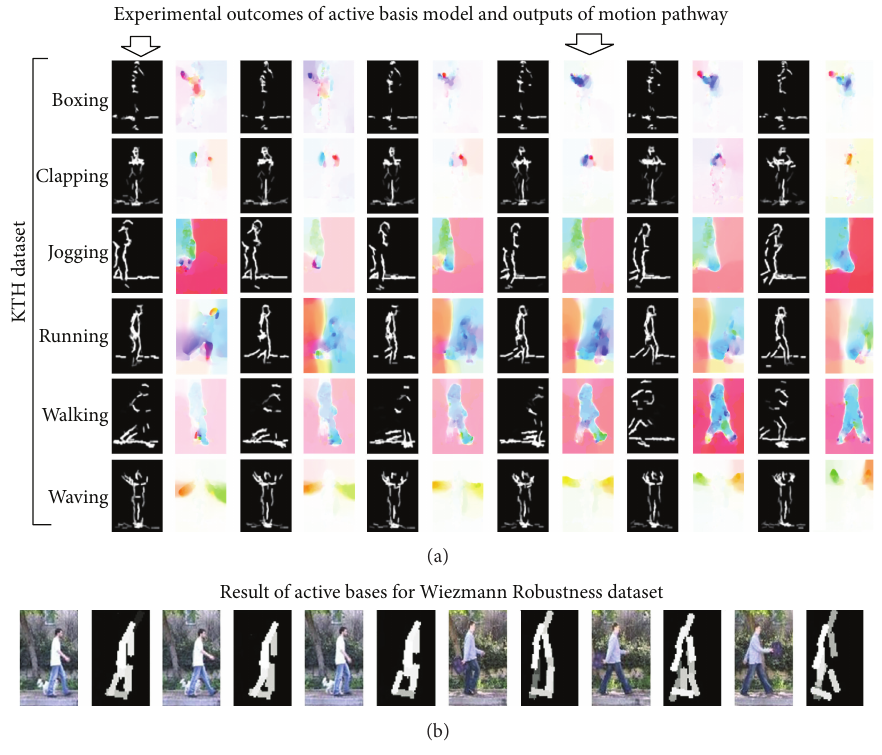
Figure 7: Simulation results for simple biological movement paradigm based on ABM [24] in the ventral processing stream and optical flow [25] in dorsal stream are shown. Each row within the panel reveals the response of ABM during the episode as well as flow generated for every different action. The set of biological movements that belongs to the biological movements is from KTH dataset [39]. (a) The simulation results of the different actions of KTH dataset along with results of optical flow simulation; (b) the figure depicts some results of Weizmann robustness dataset. It reveals an increase in the robustness of the proposed approach due to utilization of ABM [24] in the ventral stream.